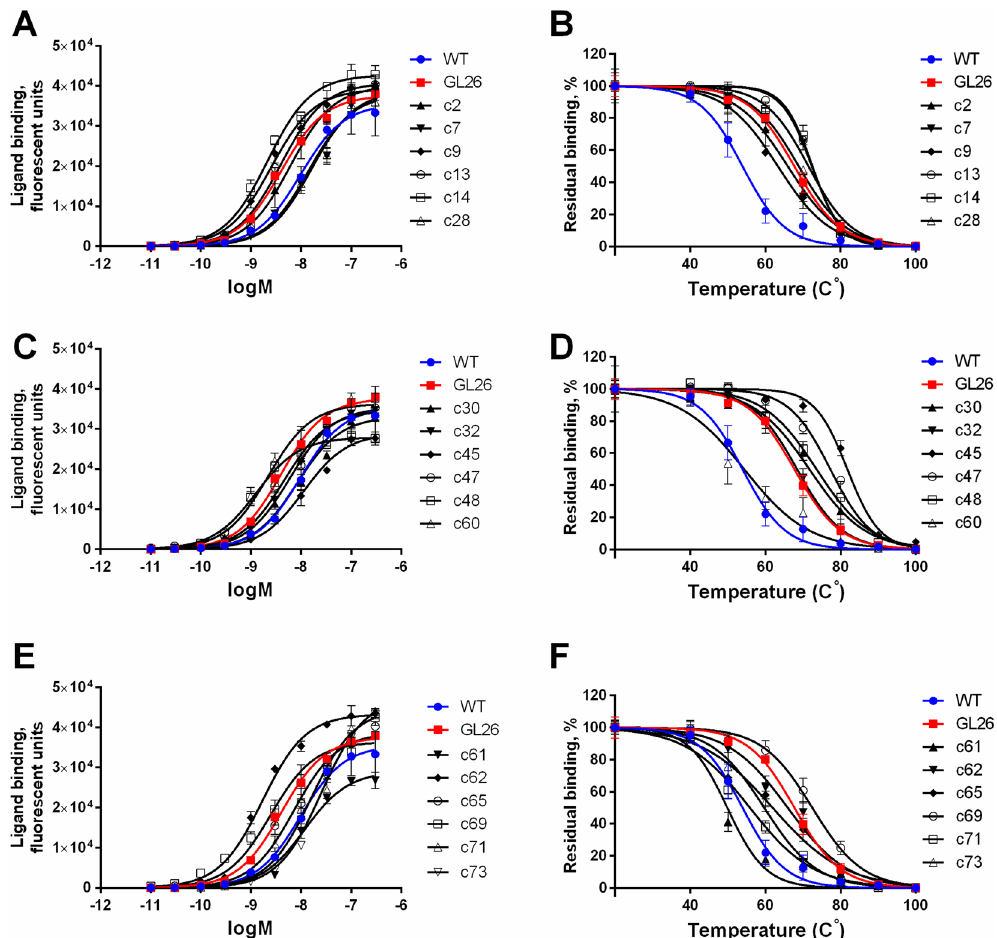
Figure 5. Expression, affinity to agonist and thermostability of OG resistant A2aR variants retrieved by YDDS. ( A,C,E ) Permeabilized yeast expressing OG resistant A2aR variants were incubated for 1 h with the indicated concentrations of CA200623, and after washing, analyzed by flow cytometry. A three-parameter logistic regression model 32 was used to analyze the experimental data. ( B,D,F ) Yeast expressing OG resistant A2aR variants were heated for 30 min at the indicated temperatures, cooled, permeabilized and incubated for 1 h with 20 nM CA200623 in the presence of 1% DM, and after washing, analyzed by flow cytometry. Data were analyzed by a non-liner regression using Boltzmann sigmoidal function. Data from one representative experiment of three independent experiments is presented as the mean ± SD of three technical